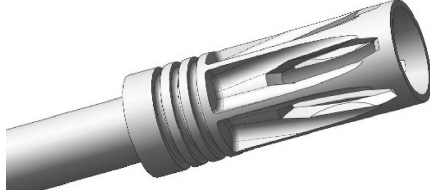
Figure 8: Schematic diagram of the muzzle